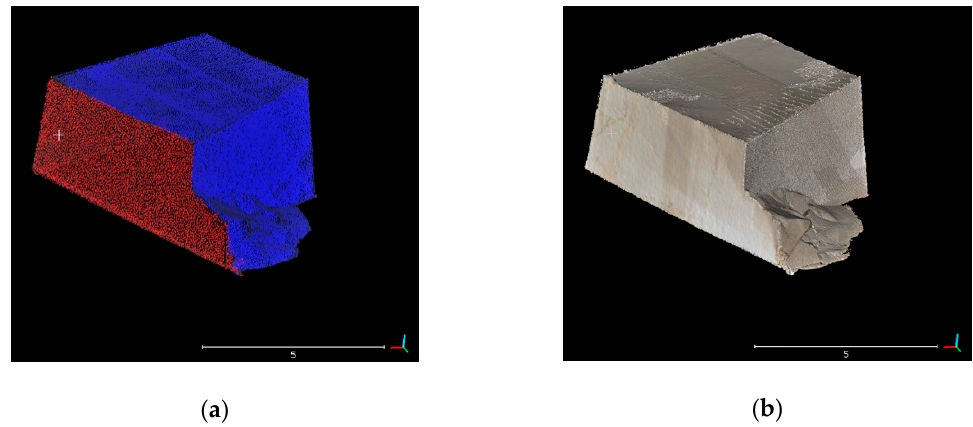
Figure 9. ( a ) Closed 3D shape made by the 2017-point cloud at the top (blue color) and the 2016-point cloud at the bottom (red color); ( b ) 3D textured model (mesh).